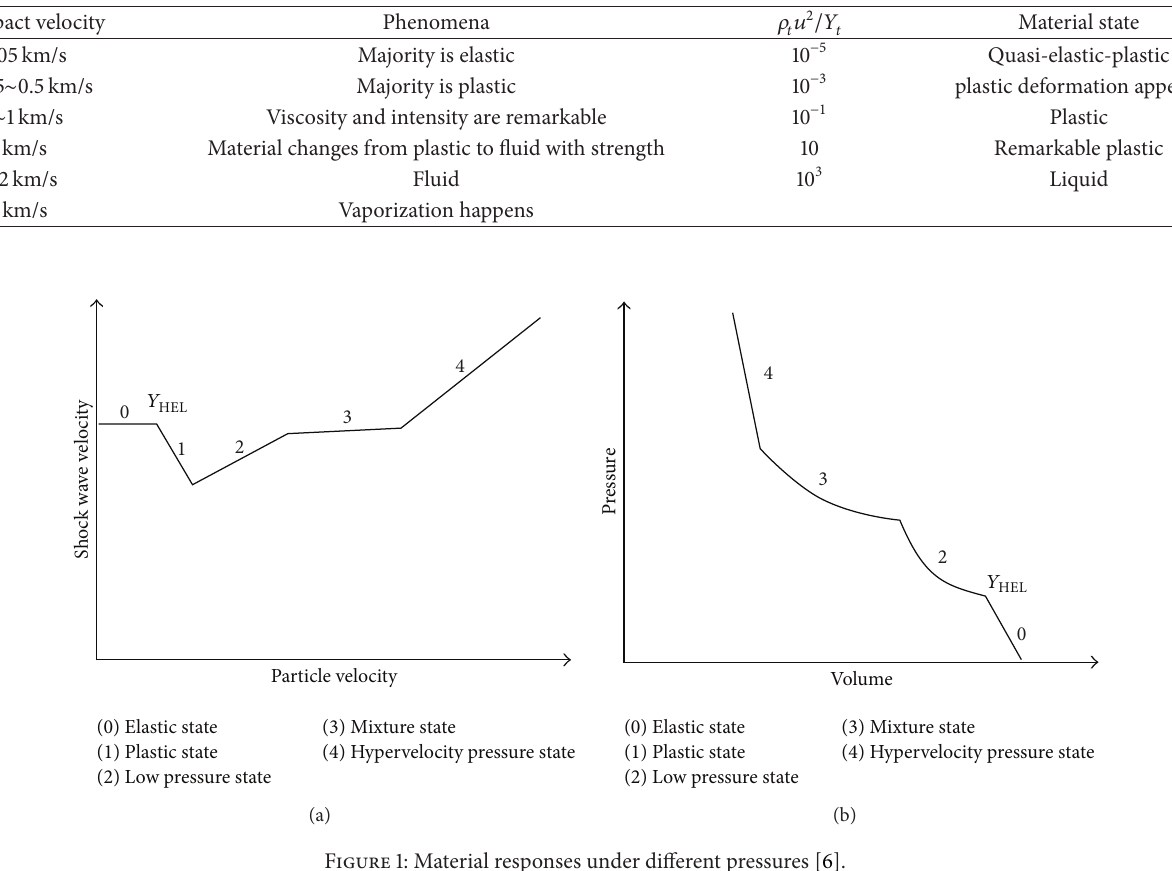
Table 1: Impact phenomena classification and state evaluation.